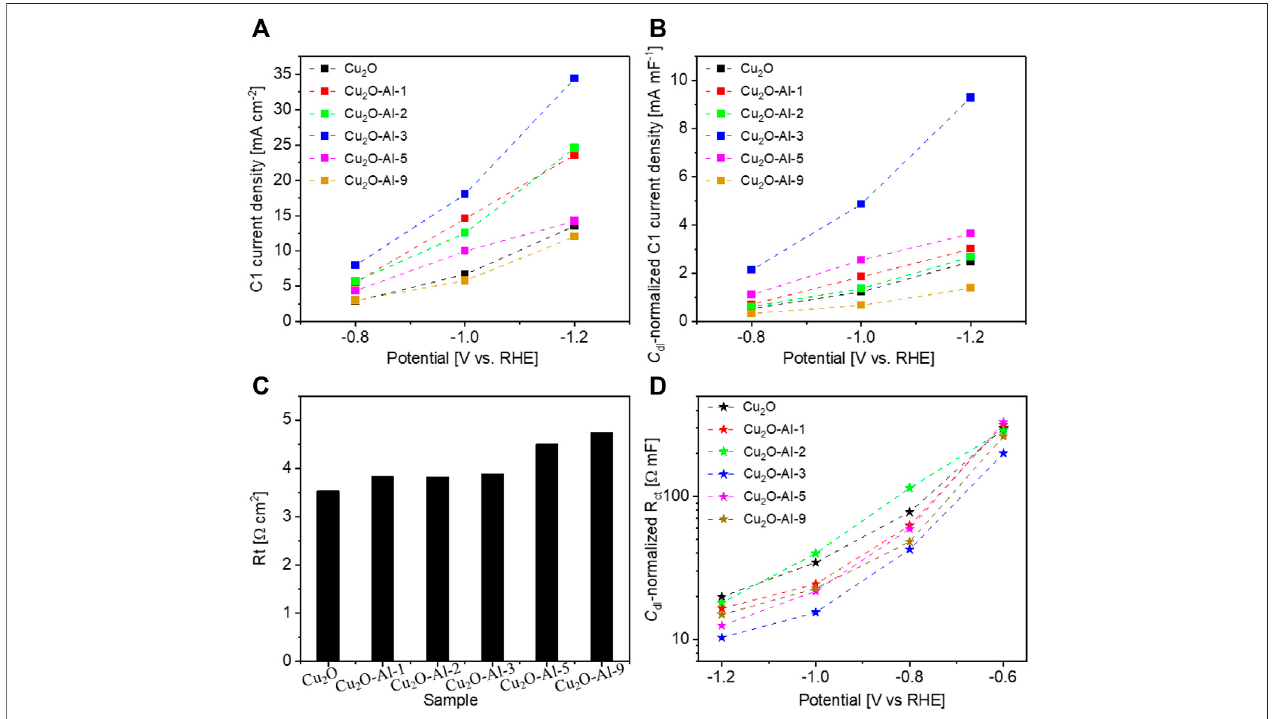
FIGURE 6 | Comparison of various electrodes: (A) geometric current density devoted to C1 products; (B) C dl -normalized current density for C1 products; (C) Charge transport resistance and (D) C dl -normalized charge transfer resistance.